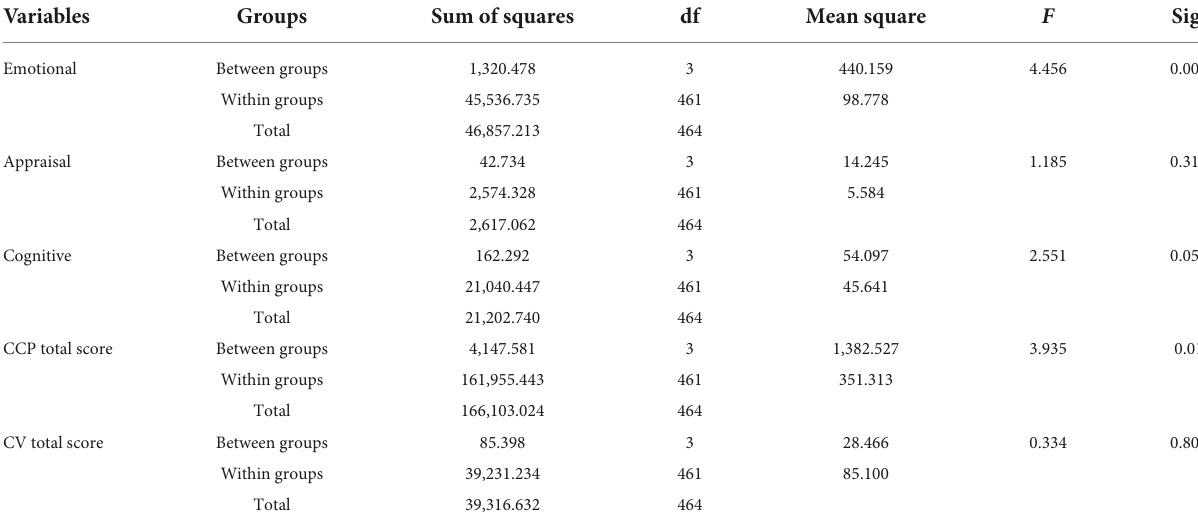
TABLE 6 Results of group differences in climate change perception (CCP) and climate values (CV) due to a career field variable. Variables Groups Sum of squares df Mean square F